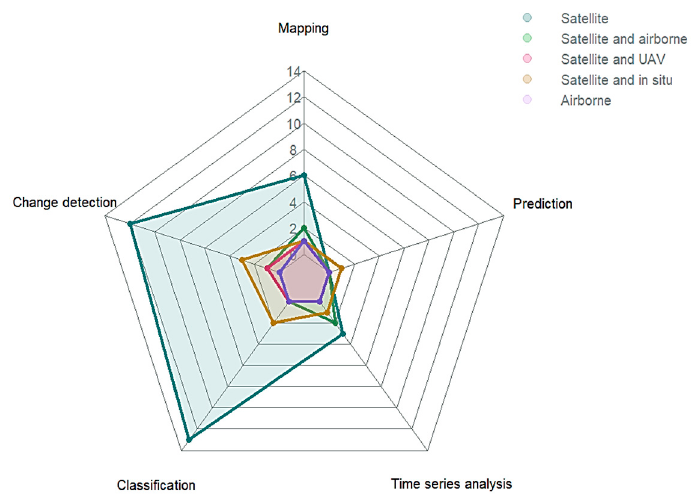
Figure 6. Distribution of the number of articles (y-axis) per monitoring strategy for each type of remote sensing data. Table 3. Average accuracy per monitoring strategy for each type of remote sensing data. Note: air- borne data were excluded, as only one article used this data type, and the accuracy was not reported.